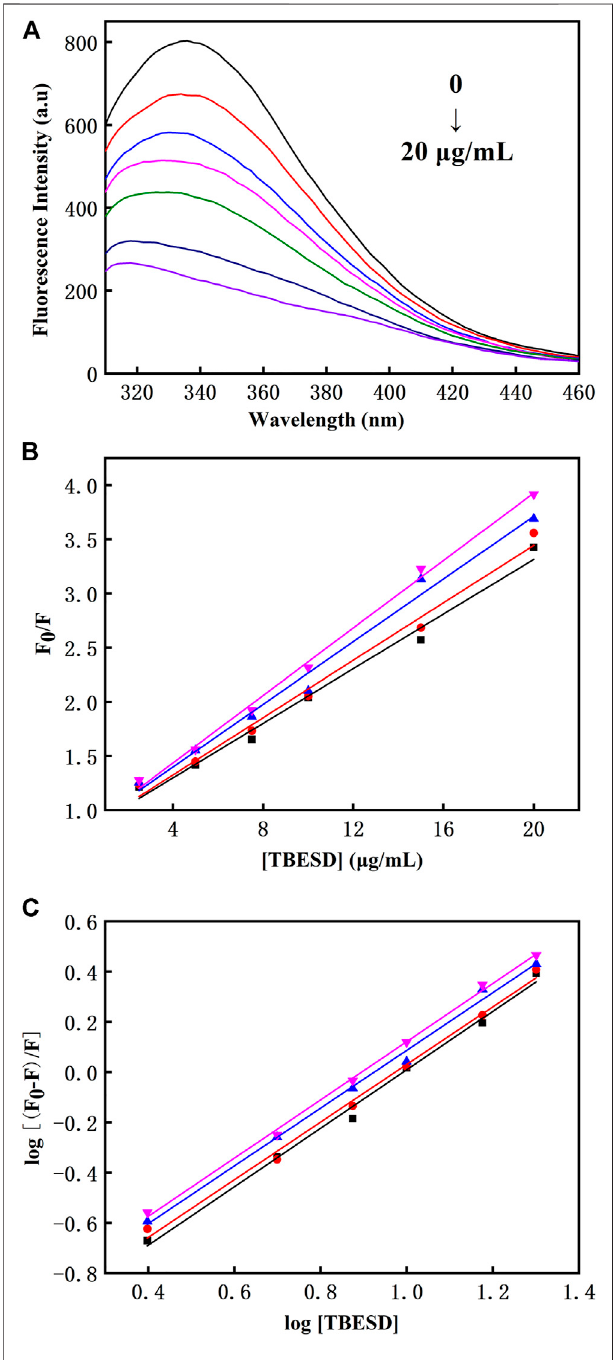
FIGURE 4 | (A) The intrinsic fl uorescence spectra of HSA (10 μ M) in the absence and presence of various concentrations of TBESD (2.5, 5, 7.5, 10, and 20 μ g/ml); (B) The Stern-Volmer plots and (C) the modi fi ed Stern-Volmer plots for fl uorescence quenching of HSA (10 μ M) by TBESD at 298 ( ■ ), 303 ( C ), 308 ( ▲ ), and 313 ( ▼ )